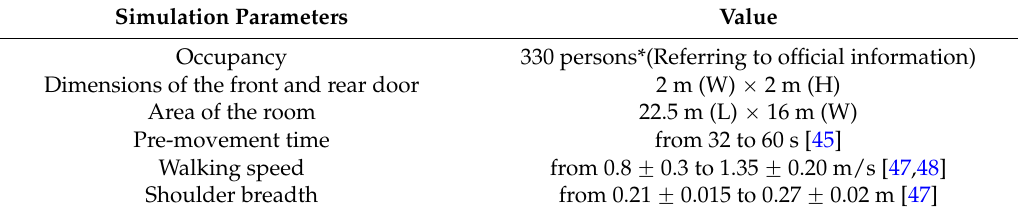
Table 5. Parameters of the evacuation model under the original status of the room